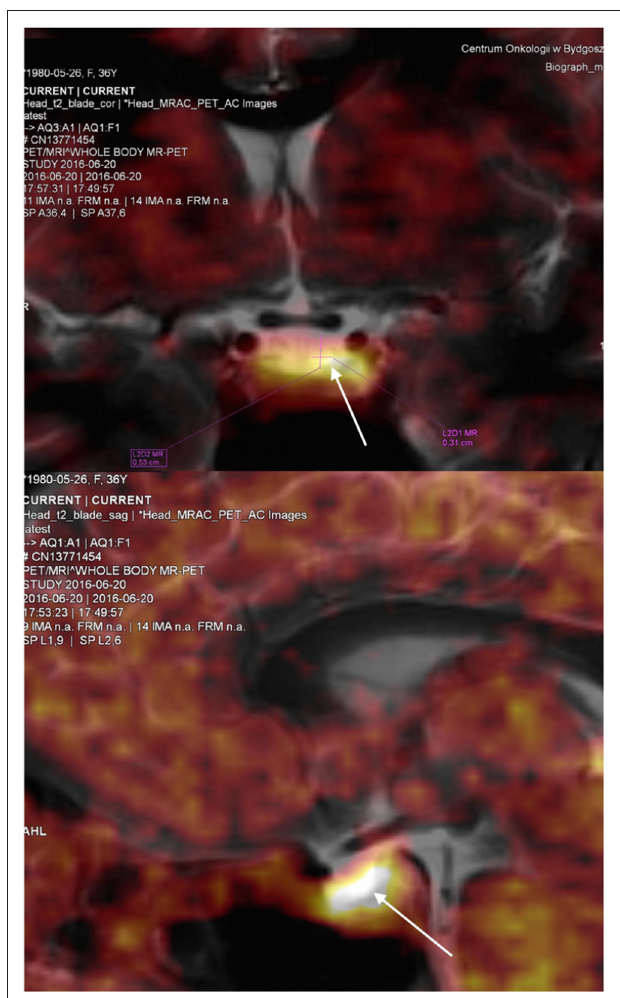
FIGURE 3 | Coronal and sagital view of the pituitary visualised by positron emission tomography using 11 C–methyl-L-methionine magnetic resonance imaging (MET-PET/MR). The study revealed the pituitary gland as being morfologically slightly thicker on the left side of the cyst with a peak of tracer uptake in this area. SUV max was 4.17 for this region compared to SUV max 3.14 in the remaining pituitary tissue. White arrows indicate the location of increased tracer